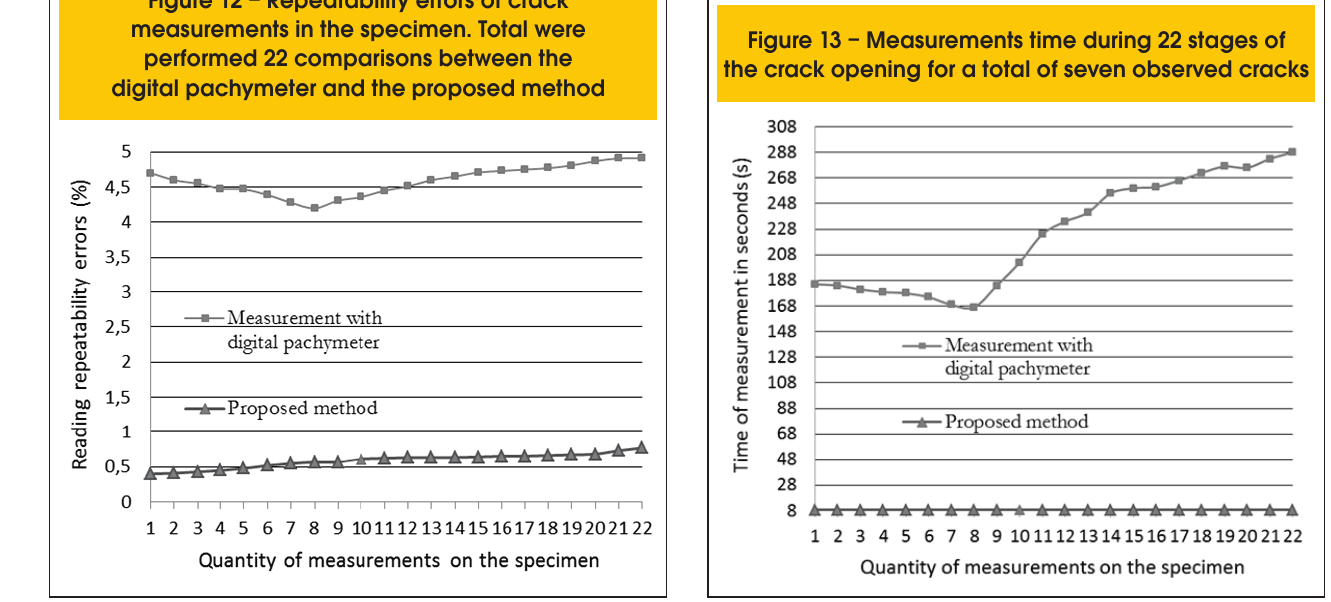
the crack opening for a total of seven observed